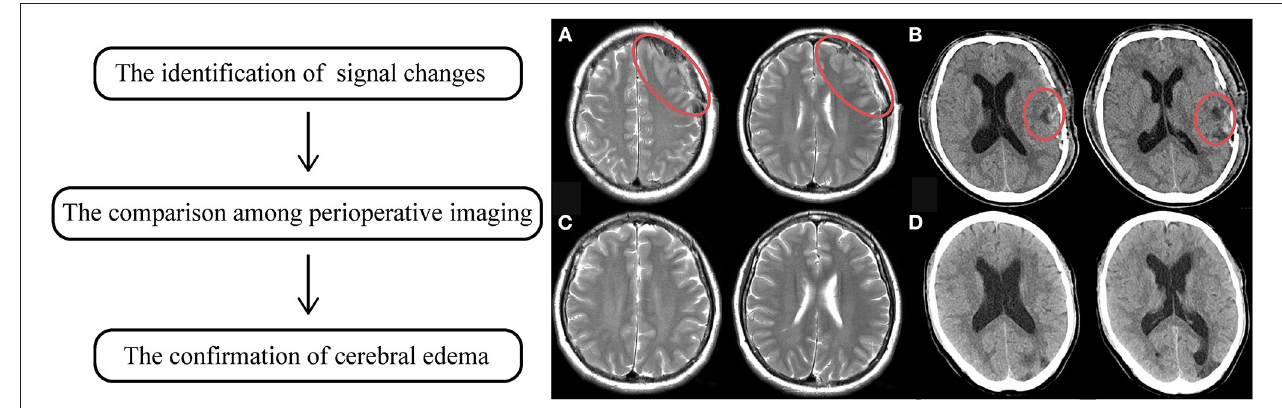
FIGURE 2 | The flowchart of the identification of cerebral edema. The left indicates the steps of identification. (A) showed high signaling changes in MRI T2 phase. (B) showed low density changes in CT, in which the red circle manifested altered regions. (C,D) was preoperative radiological sequences of (A,B) , respectively. It was proven that those signaling changes just occurred after